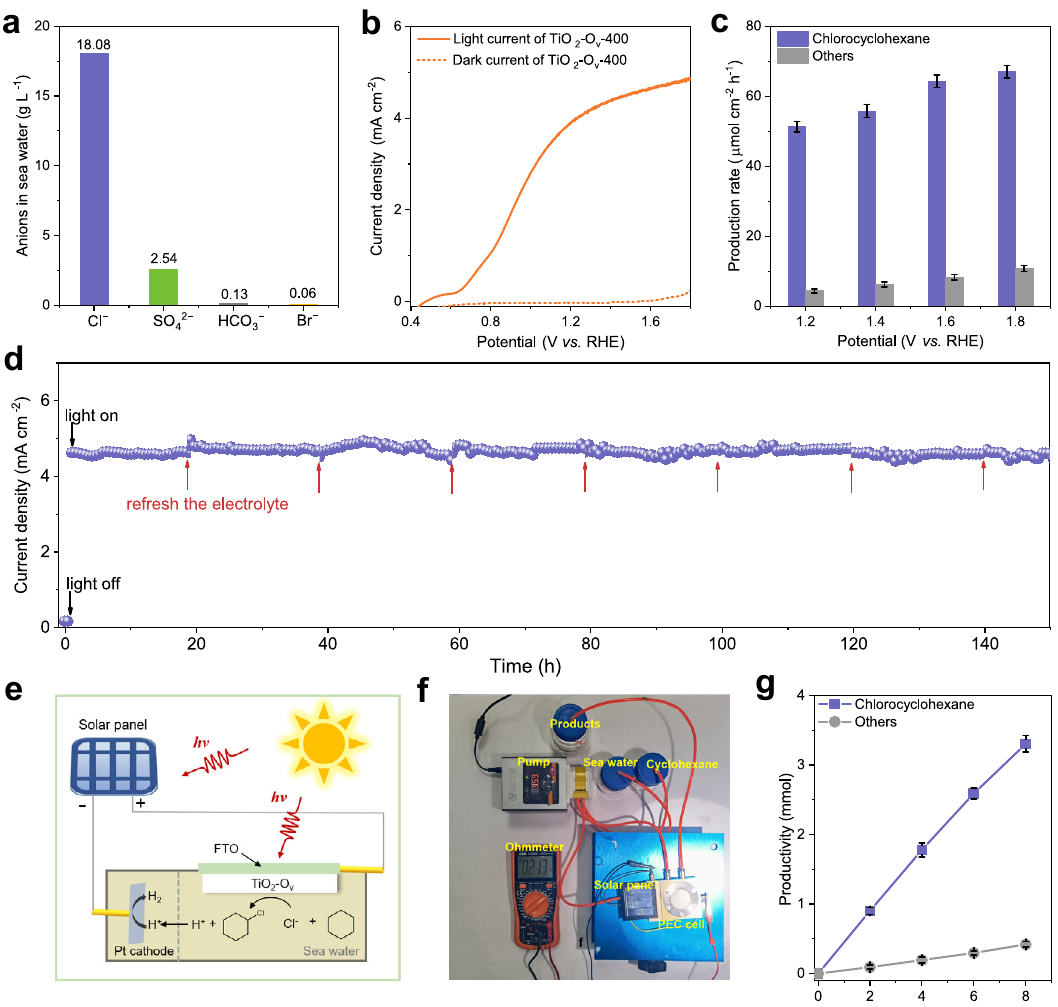
Fig. 7 PEC chlorination based on seawater. a The concentration of the main anions in the natural seawater collected from the Yellow Sea, Shandong Province, China. b LSV curves at scan rate of 10 mV s − 1 of TiO 2 -O v -400 photoanode in seawater under AM 1.5G (100 mWcm − 2 ) illumination (solid line) or in the dark (dashed line). c Production rate of chlorocyclohexane on TiO 2 -O v -400 photoanode using seawater as electrolyte under AM 1.5G (100 mW cm − 2 ) illumination at different potentials for 2 h in an H-type photoelectrocell. d Current-time ( I-t ) curve of TiO 2 -O v -400 for PEC cyclohexane chlorination in seawater for 150 h reaction. e Schematic illustration of the self-powered PEC system. f The photo of the self-powered PEC system under AM 1.5G (100 mW cm − 2 ) illumination. g Productivity of the PEC chlorination products in self-powered PEC system. The error bars represent the relative deviation, which is within